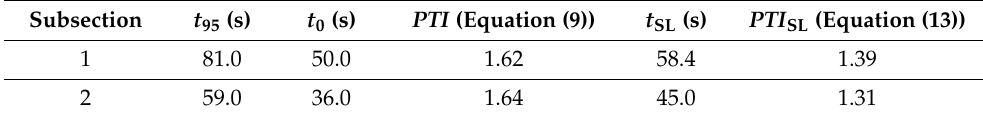
Table 5. Summary of calculation data and analysis results regarding PTI and PTI SL